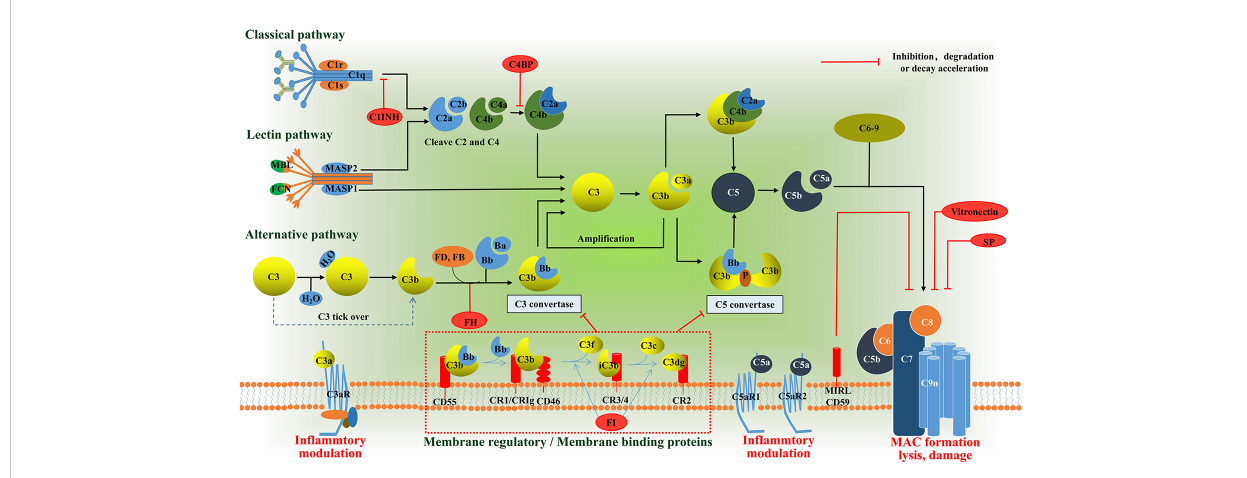
FIGURE 1 Schematic diagram of the complement system. The complement system can be activated via the classical pathway (CP), the lectin pathway (LP), or the alternative pathway (AP). These three pathways have their own pattern in forming C3 convertase: C4b2a or C3bBb. The C3a binds its anaphylatoxin receptor the C3aR, while C3b can induce phagocytosis of opsonized targets and its further degradation products, iC3b, C3c and C3d/ C3dg are able to bind various complement receptors. C3b can also bind to the former C3 convertase, which then results in formation of the C5 convertases: C4bC2aC3b or C3bBbC3b. The C5 convertases cleaves C5 into the C5a and C5b. The C5a binds its anaphylatoxin receptor the C5aR1 and C5aR2, whereas C5b, C6, C7, C8 and up to 16 molecules of C9 bind together to form the MAC, which forms a channel on the surface of targeted cells and causes cells to swell and lysis. In addition to the rate-limiting effect of the C3 and C5 convertase, there are also soluble regulatory proteins (i.e., C1INH, C4BP, and FH) and membrane regulatory proteins (i.e., CR1, CD46, and CD55) that regulate the activation of complement cascades. The anaphylatoxins C3a and C5a mediate in fl ammatory mudulation through binding to their receptors, respectively. MBL, mannose binding lectin; MASP, MBL associated serine protease; FD, factor D; FB, factor B; FH, factor H; C1INH, C1 inhibitor; FI, factor I; C4BP, C4b-binding protein; CR, complement receptor; MAC, membrane attack complex, SP, S